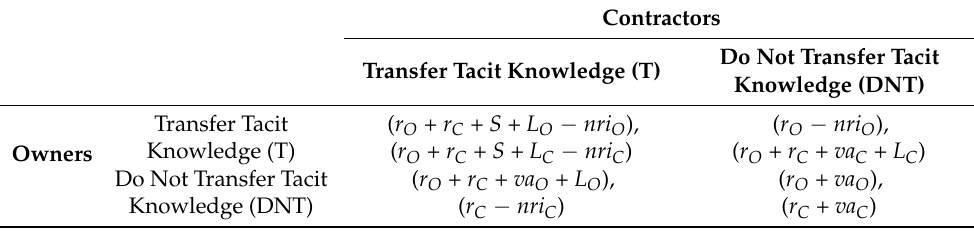
Table 4. Payoff matrix of tacit knowledge-transferring game in construction projects.